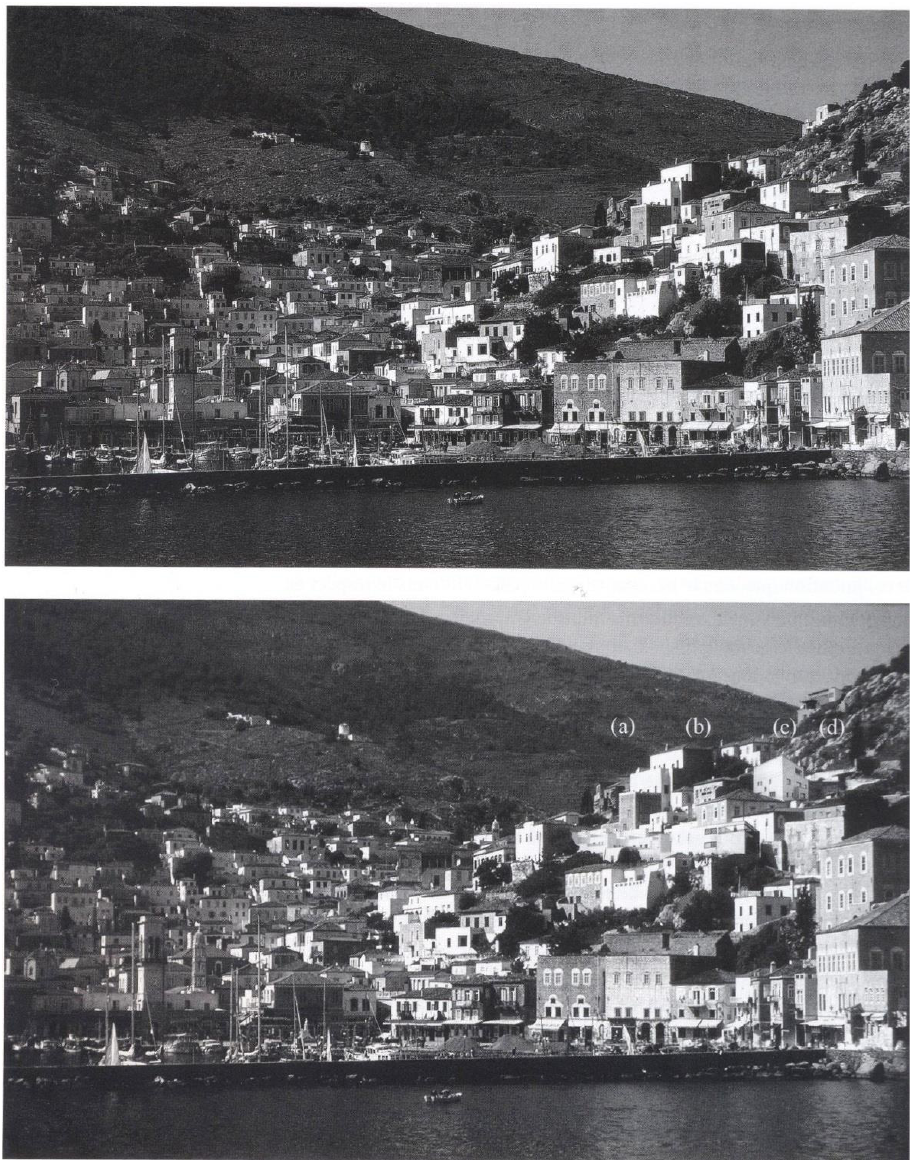
Figure 2a, b. a): Hydra’s urban landscape; b): a photomontage with the inclusion of some modern architectural major works: a) part of Alvaro Siza’s ensemble at Évora (1977); b)+d) Le Corbusier’s and Hans Scharoun Weisenhoff houses (1927); c) Adolf Loos Moller House (1927). In Von MEISS, Pierre, De la forme au lieu+ de la techtonique , fig. 63, p.